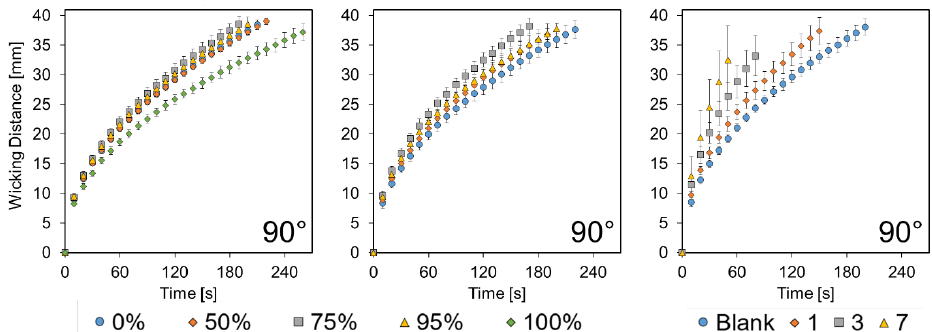
Figure A7. Distance vs. time plots for untaped angled wicking. Data presented as mean ± SD. n = 5.